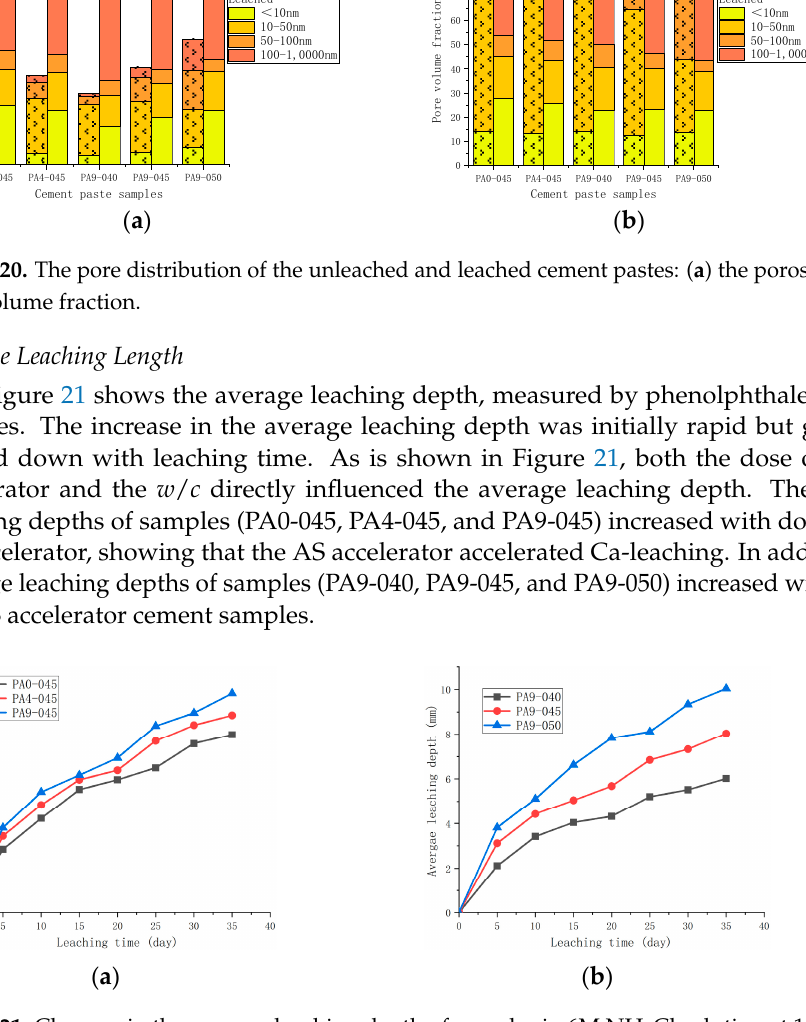
Figure 21. Changes in the average leaching depth of samples in 6M NH 4 Cl solution at 1cm/s with leaching time: ( a ) different dosages of the AS accelerator; ( b ) different w/c.